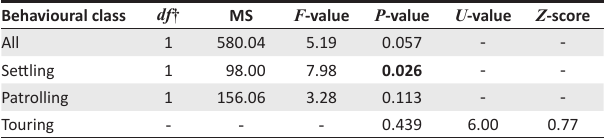
n , number; SE, standard error. TABLE 2: Results of one-way analyses of variance and a Mann–Whitney U test to compare the number of incidences in all and within each studied butterfly behavioural classification across natural and invaded forest patches in a dairy farming matrix.